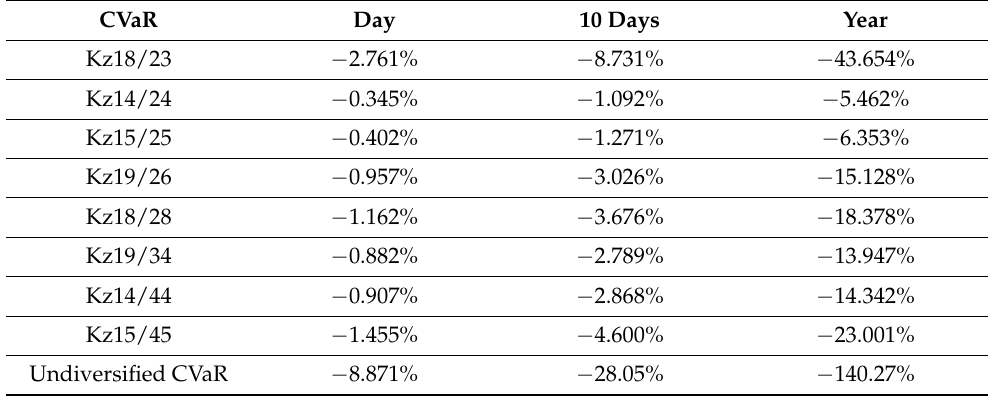
Table 2. The Conditional Value at risk for Kazakhstan’s Sovereign Bonds.